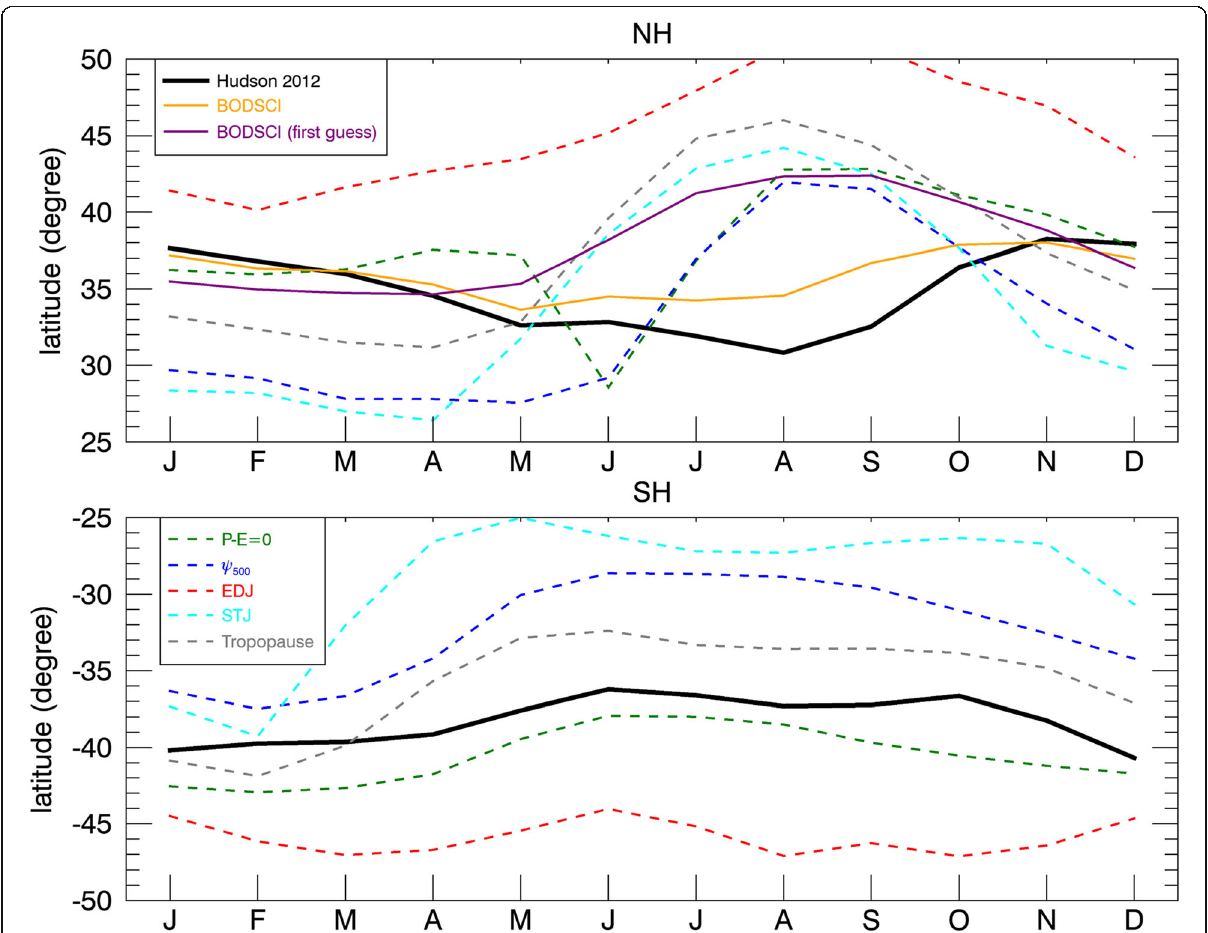
Fig. 4 Seasonal cycle of tropical width metrics from TCO data (solid lines) and ERA-Interim reanalysis (dashed lines) over their common time period (1979 – 2010). The EDJ metric has been shifted 5° equatorward in the